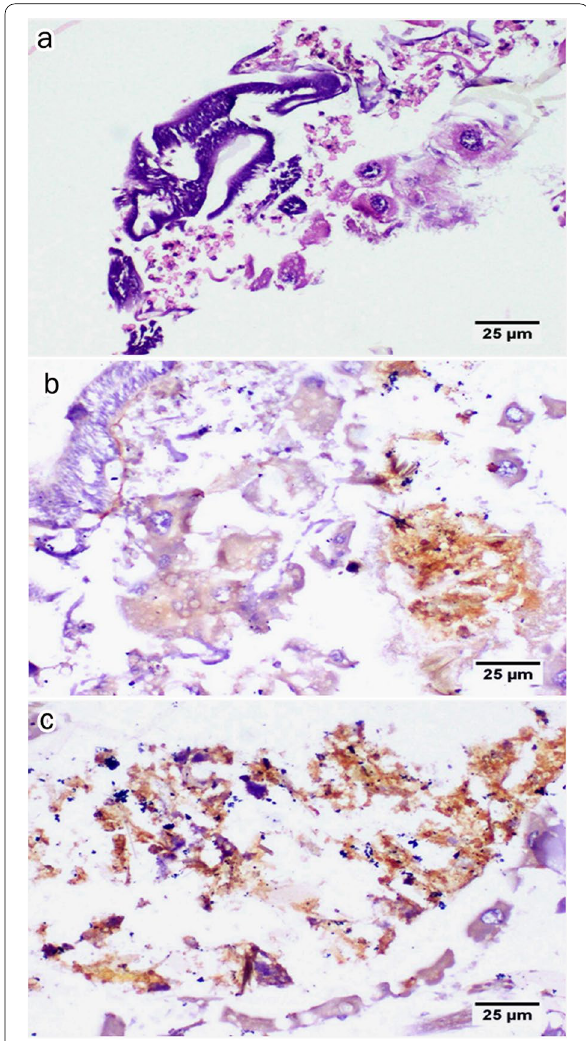
Fig. 3 Light micrographs show Caspase-3 expression in the larvae midgut cells of the third instar of Culex pipiens . a Untreated larvae. b 24 h after treatment, notice the very mild apoptotic marker expression. c 48 h after treatment, notice the higher level of apoptotic marker